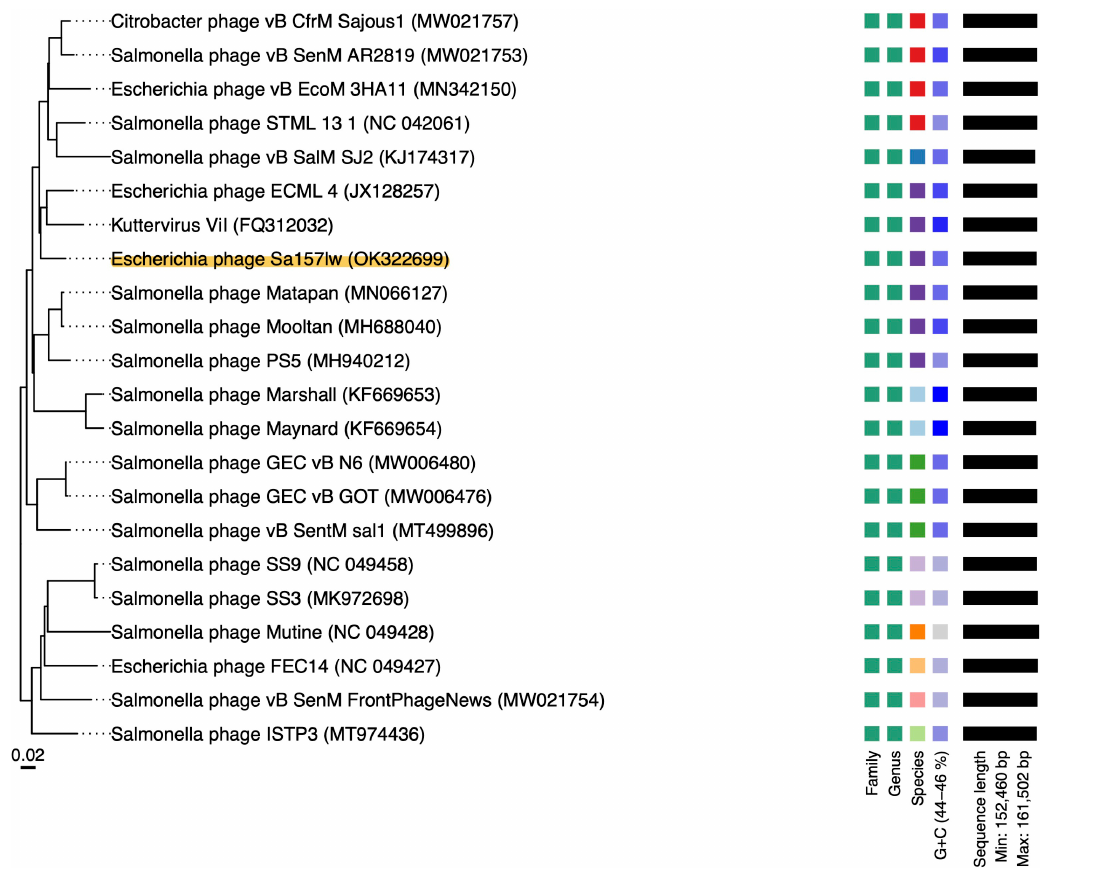
O157:H7 (ATCC 35150) and Salmonella Typhimurium